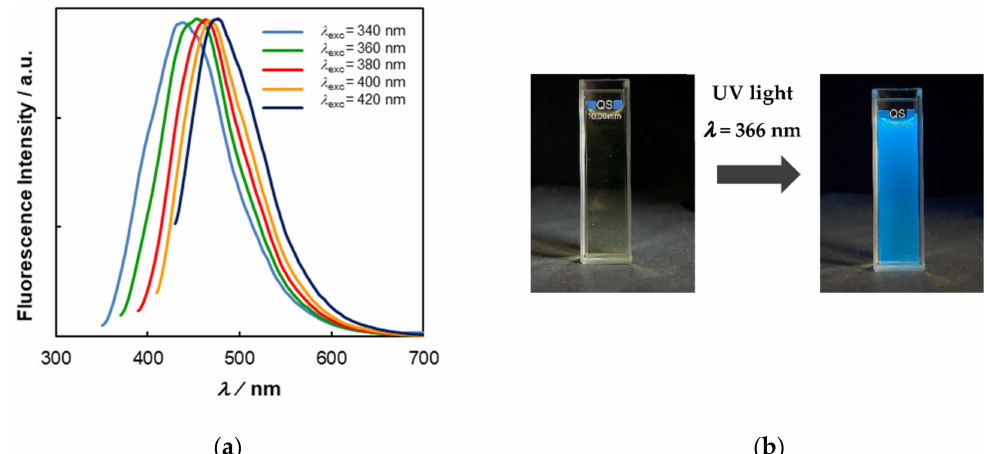
Figure 3. Normalized emission spectra of aqueous dispersions (0.1 mg/mL) of C-dots (HTC) obtained from CGsSV (excitation in the 340–420 nm range) ( a ) and aqueous dispersion of C-dots samples under daylight and UV–Vis excitation ( b ).